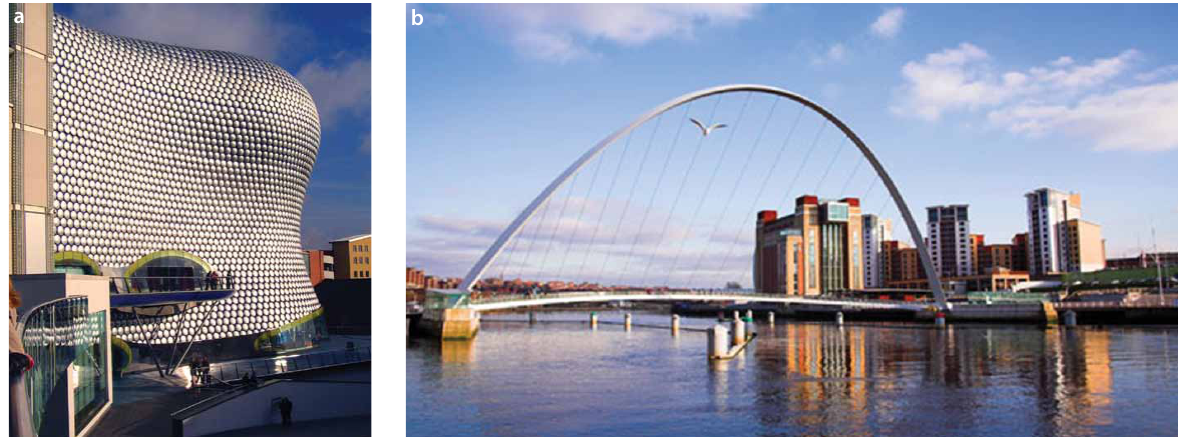
fig. 3. Examples of urban regeneration in the united Kingdom: a – Future System Selfridges building in Birmingham ( Source : http://en.wikipedia.org/wiki/Big_City_Plan); b – newcastle–Gateshead as an example of urban regeneration ( Source :